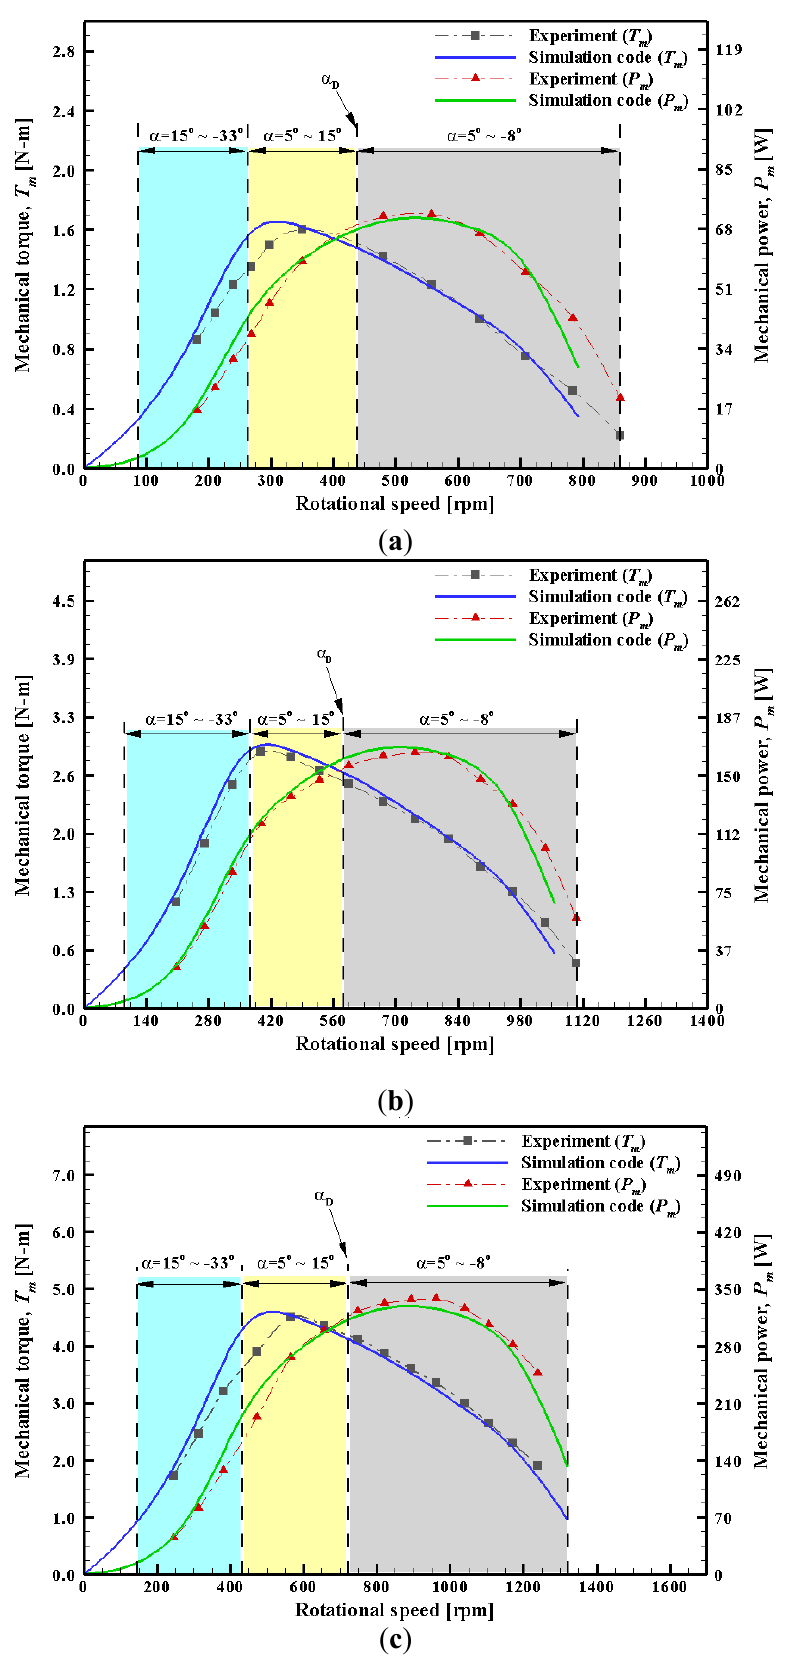
Figure 13. The comparison of mechanical torques/powers between the experiment and simulation results at wind speed of ( a ) 6 m/s; ( b ) 8 m/s; ( c ) 10 m/s and ( d ) 12